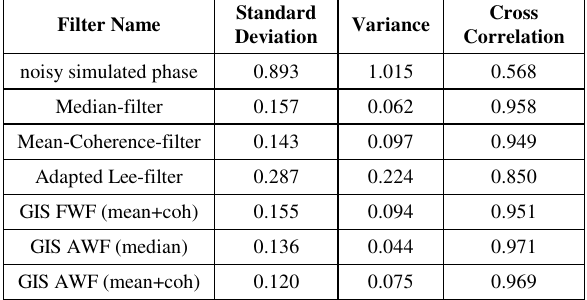
Table 2. Results of filtering based on real InSAR phases